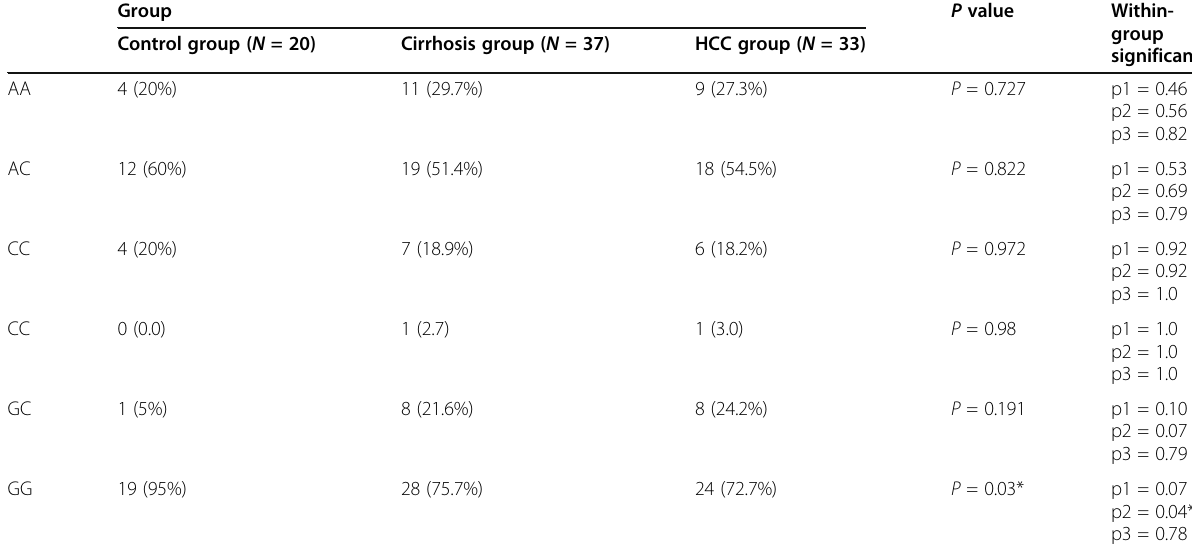
Table 5 Comparison of different IL-18 genotypes in the studied groups Group P value Within-